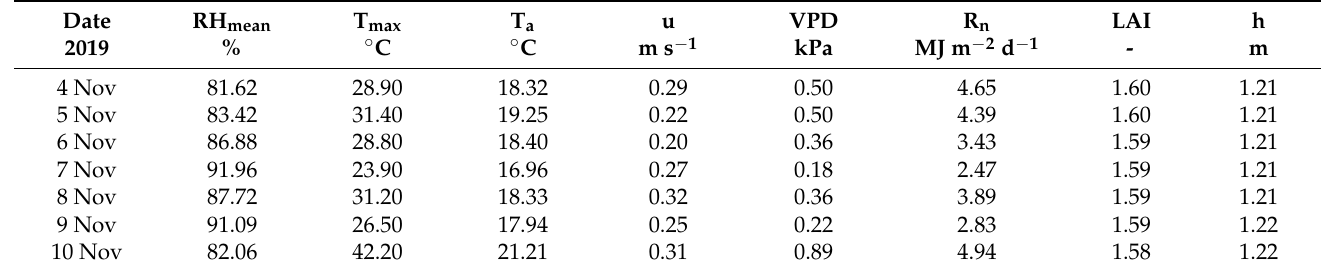
Table 4. Daily meteorological conditions and tomato plant parameters for selected periods.